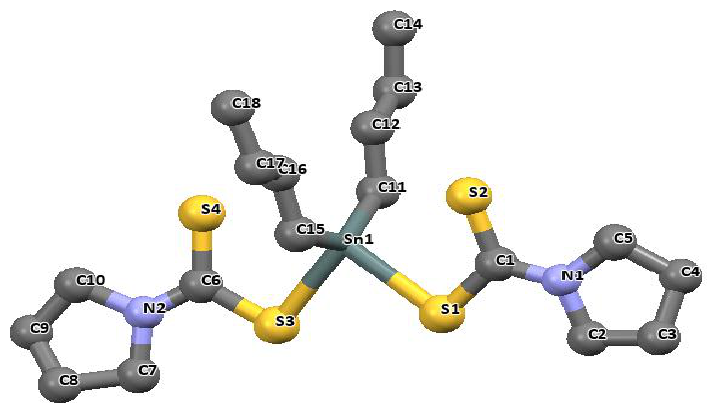
Figure 8. The molecular structure of dibutyltin(IV) pyrrolidinedithiocarbamate complex [Sn{S 2 CN(CH 2 ) 4 } 2 n-Bu 2 ] and the atom numbering (For clarity, H atoms were omitted). Redrawn from [84], with permission from Elsevier (Copyright 2018).